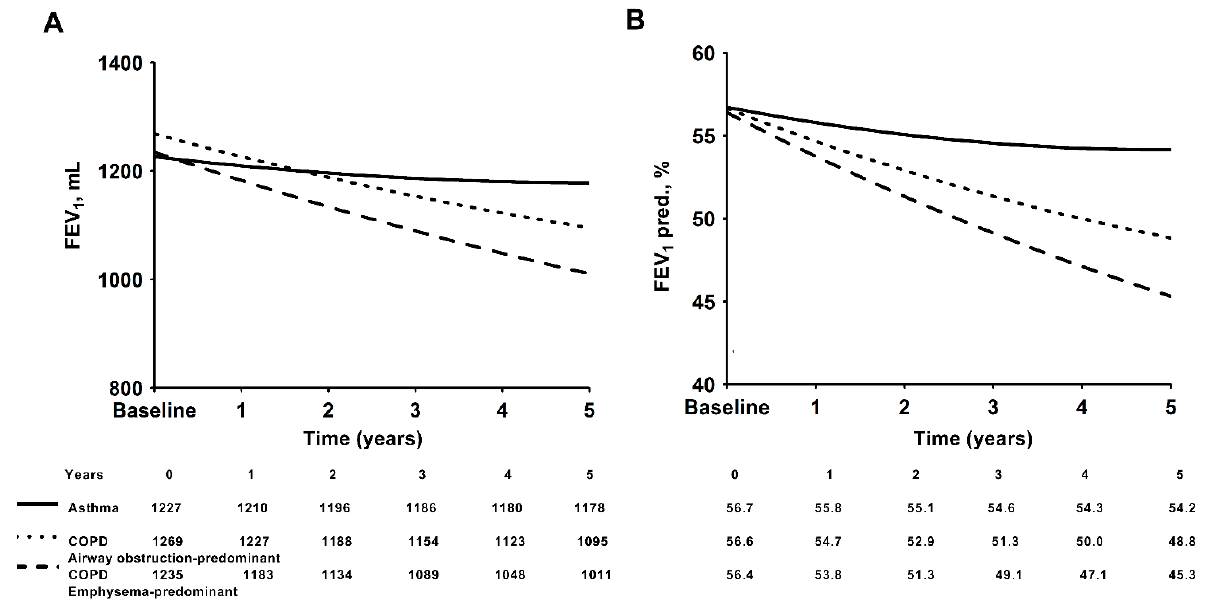
Figure 3. Modeled forced vital capacity (FVC) decline over time in milliliters ( A ) or as a percentage of the predicted value ( B ) in the three groups.